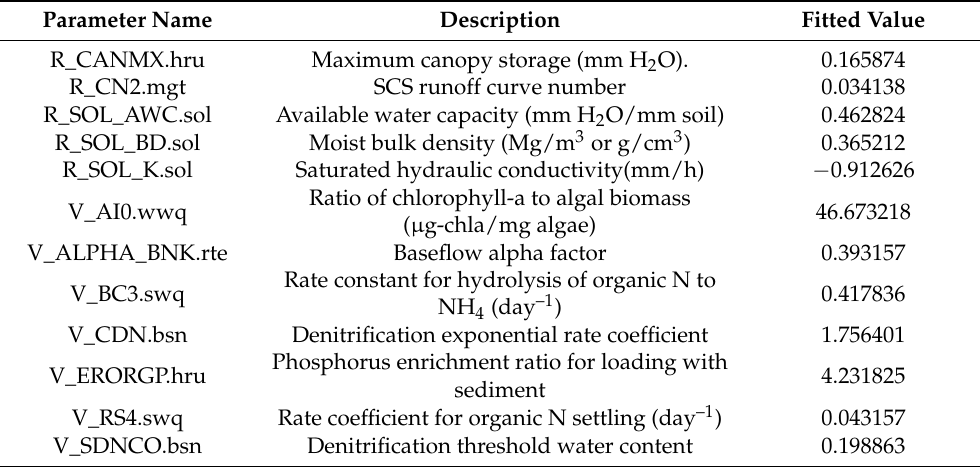
Table 2. Optimal Parameter Values After Calibration.